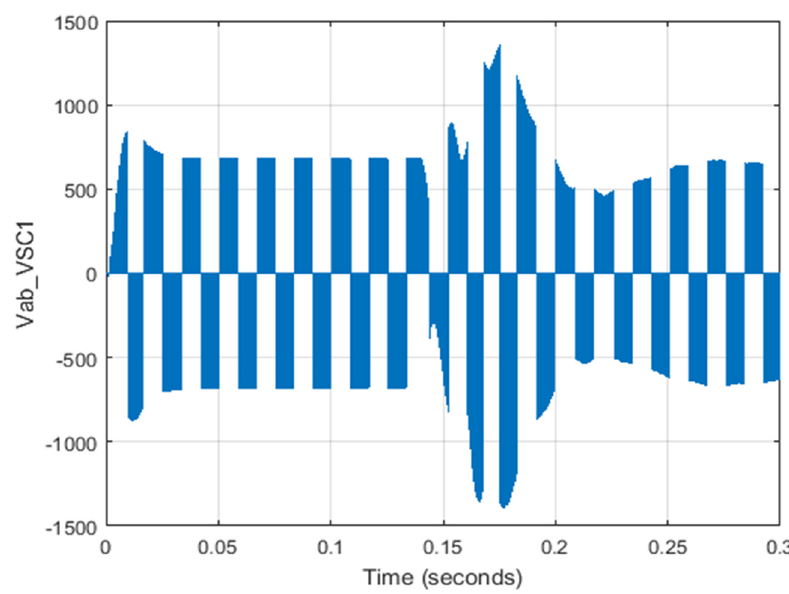
Figure 16. Two-phase voltage ab for VSC-1.